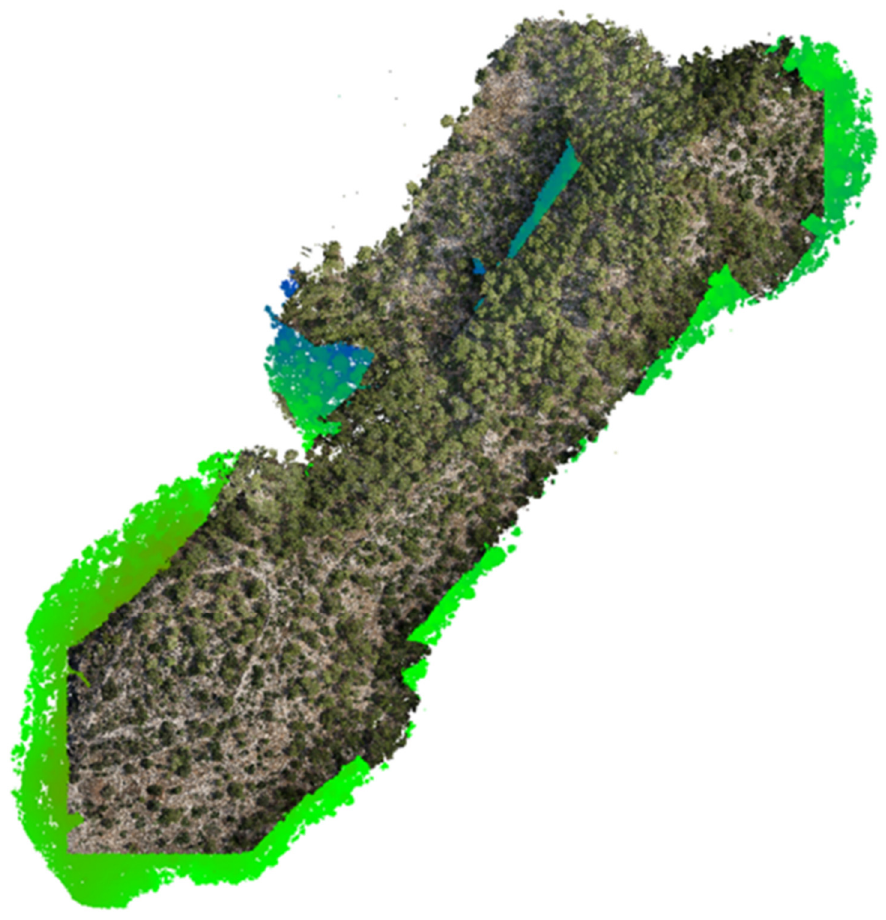
Figure 3. Illustrations of ( a ) mission information (yellow asterisk shows the study site) and the ( b ) used UAV and base station along the west coast of Dana Island.